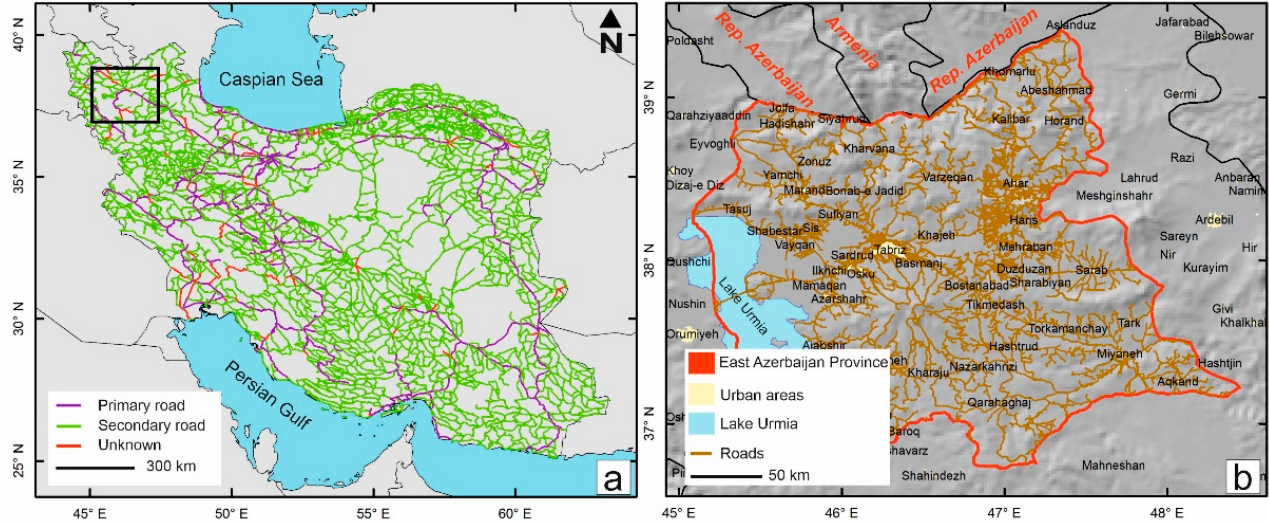
Figure 1. ( a ) Road network map of Iran. The black box denotes the study area. ( b ) Road network of East Azerbaijan Province, Iran, the study area.